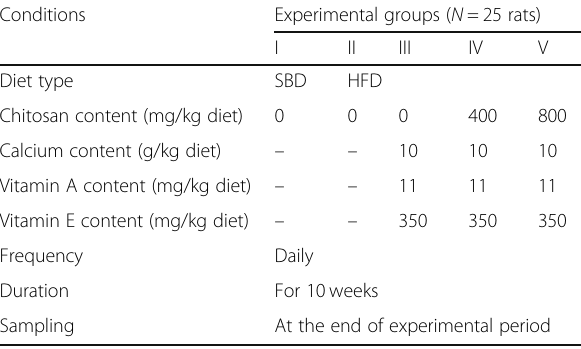
Table 2 Summarized experimental design of the